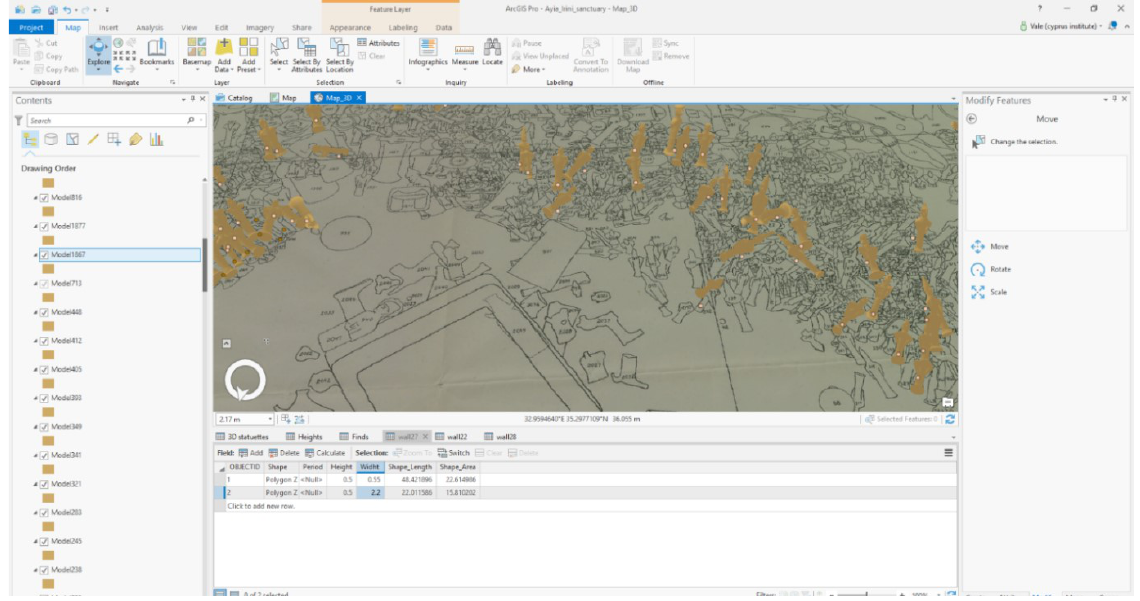
Fig. 2. 3D models of the finds integrated in the 3D GIS (©